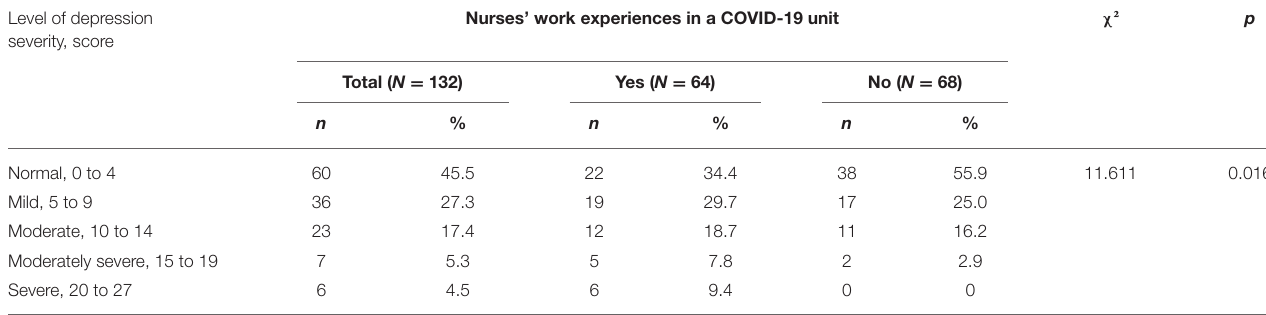
TABLE 1 | Levels of depression in participants ( N = 132).